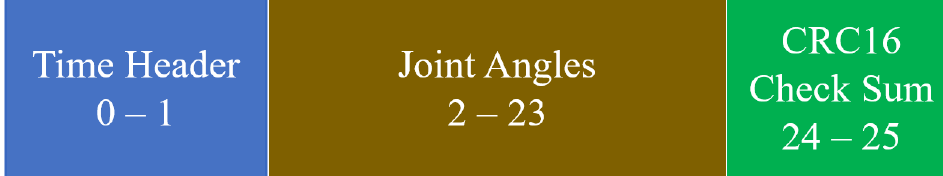
Figure 4. Designed Communication